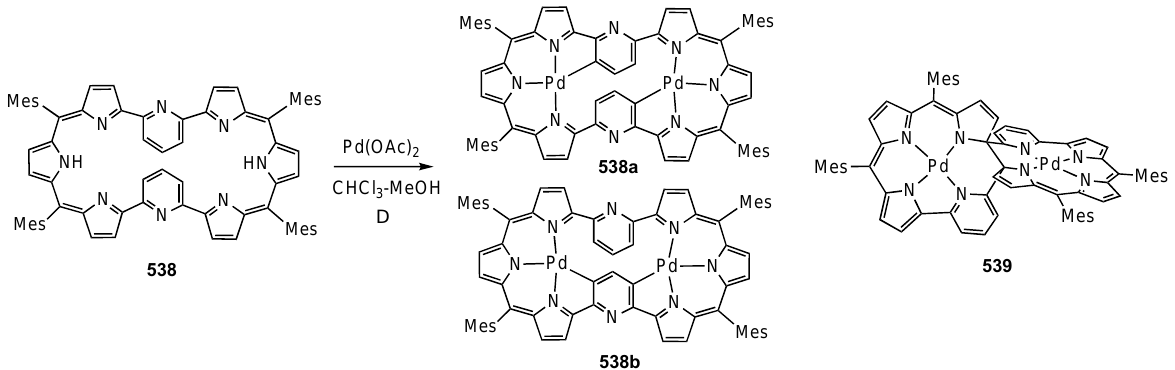
Molecules 2023 , 28 , x FOR PEER REVIEW Scheme 81. Organometallic derivatives of doubly N-confused hexaphyrins. Scheme 81. Organometallic derivatives of doubly N-confused hexaphyrins.